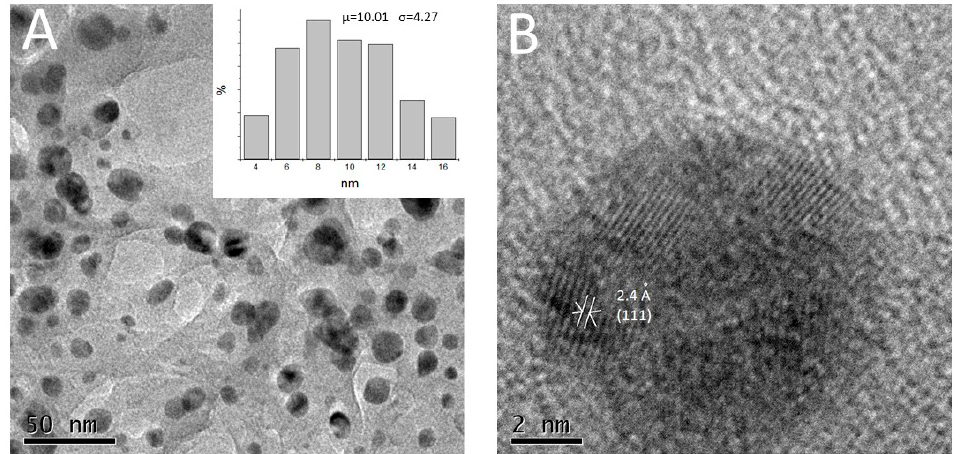
Figure 3. Characterization of synthesized biogenic silver nanoparticles from clove extract. ( A ) Micrograph of transmission electron microscopy, the insert shows size distribution and ( B ) high-resolution transmission electron microscopy micrograph.